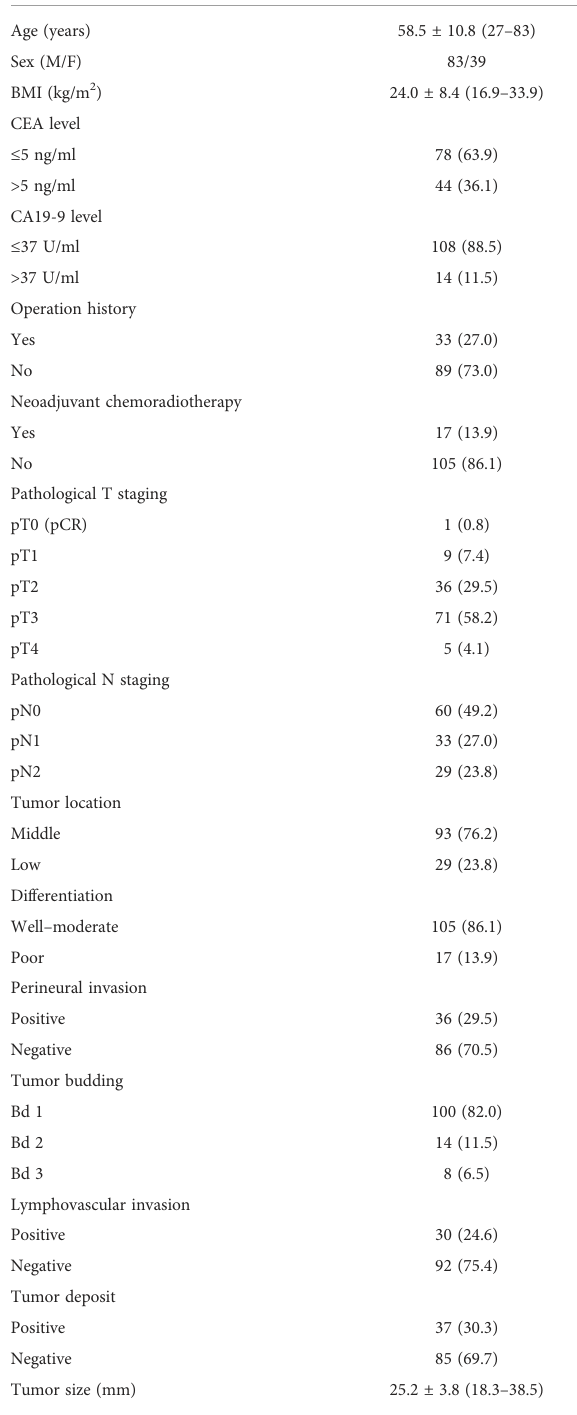
TABLE 1 Clinical and pathological characteristics in patients with rectal cancer.